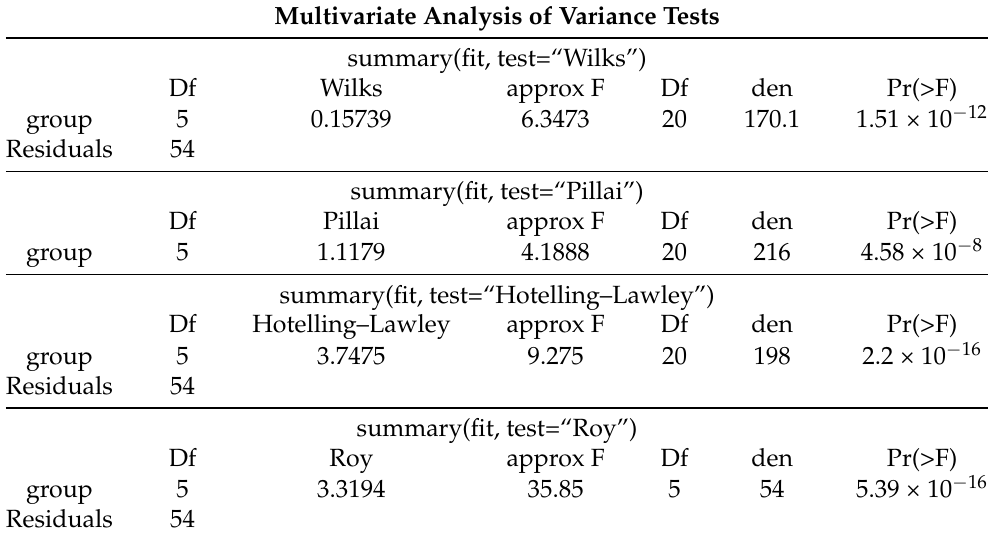
Table 2. MANOVA: R p -value results.